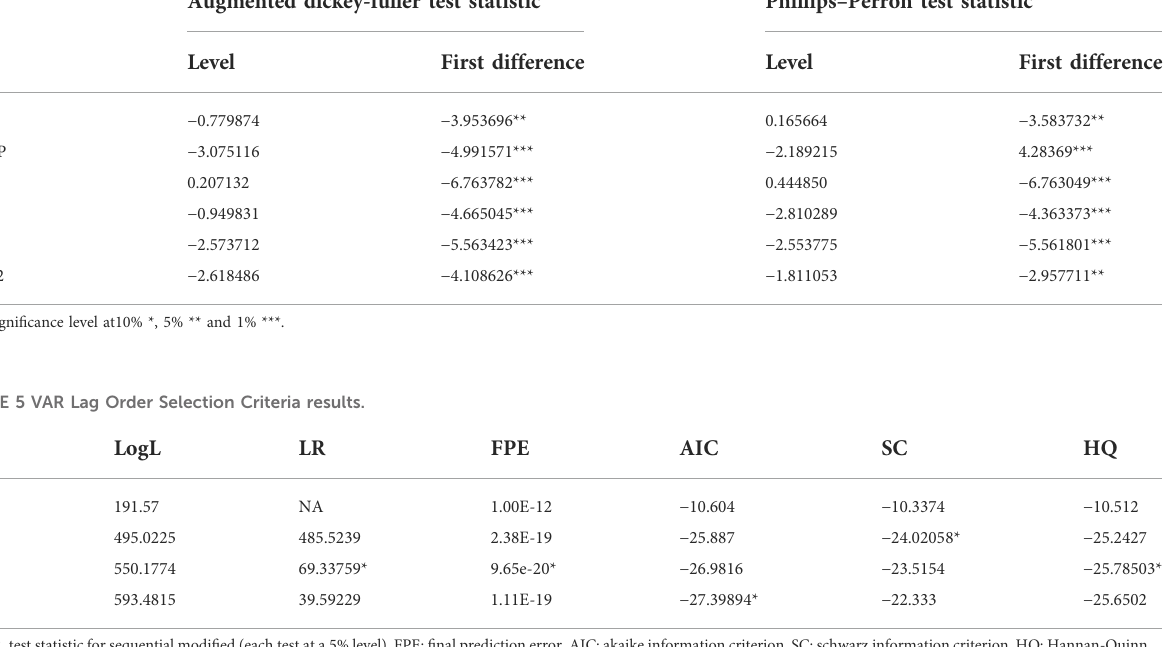
TABLE 4 Unit Root tests results.